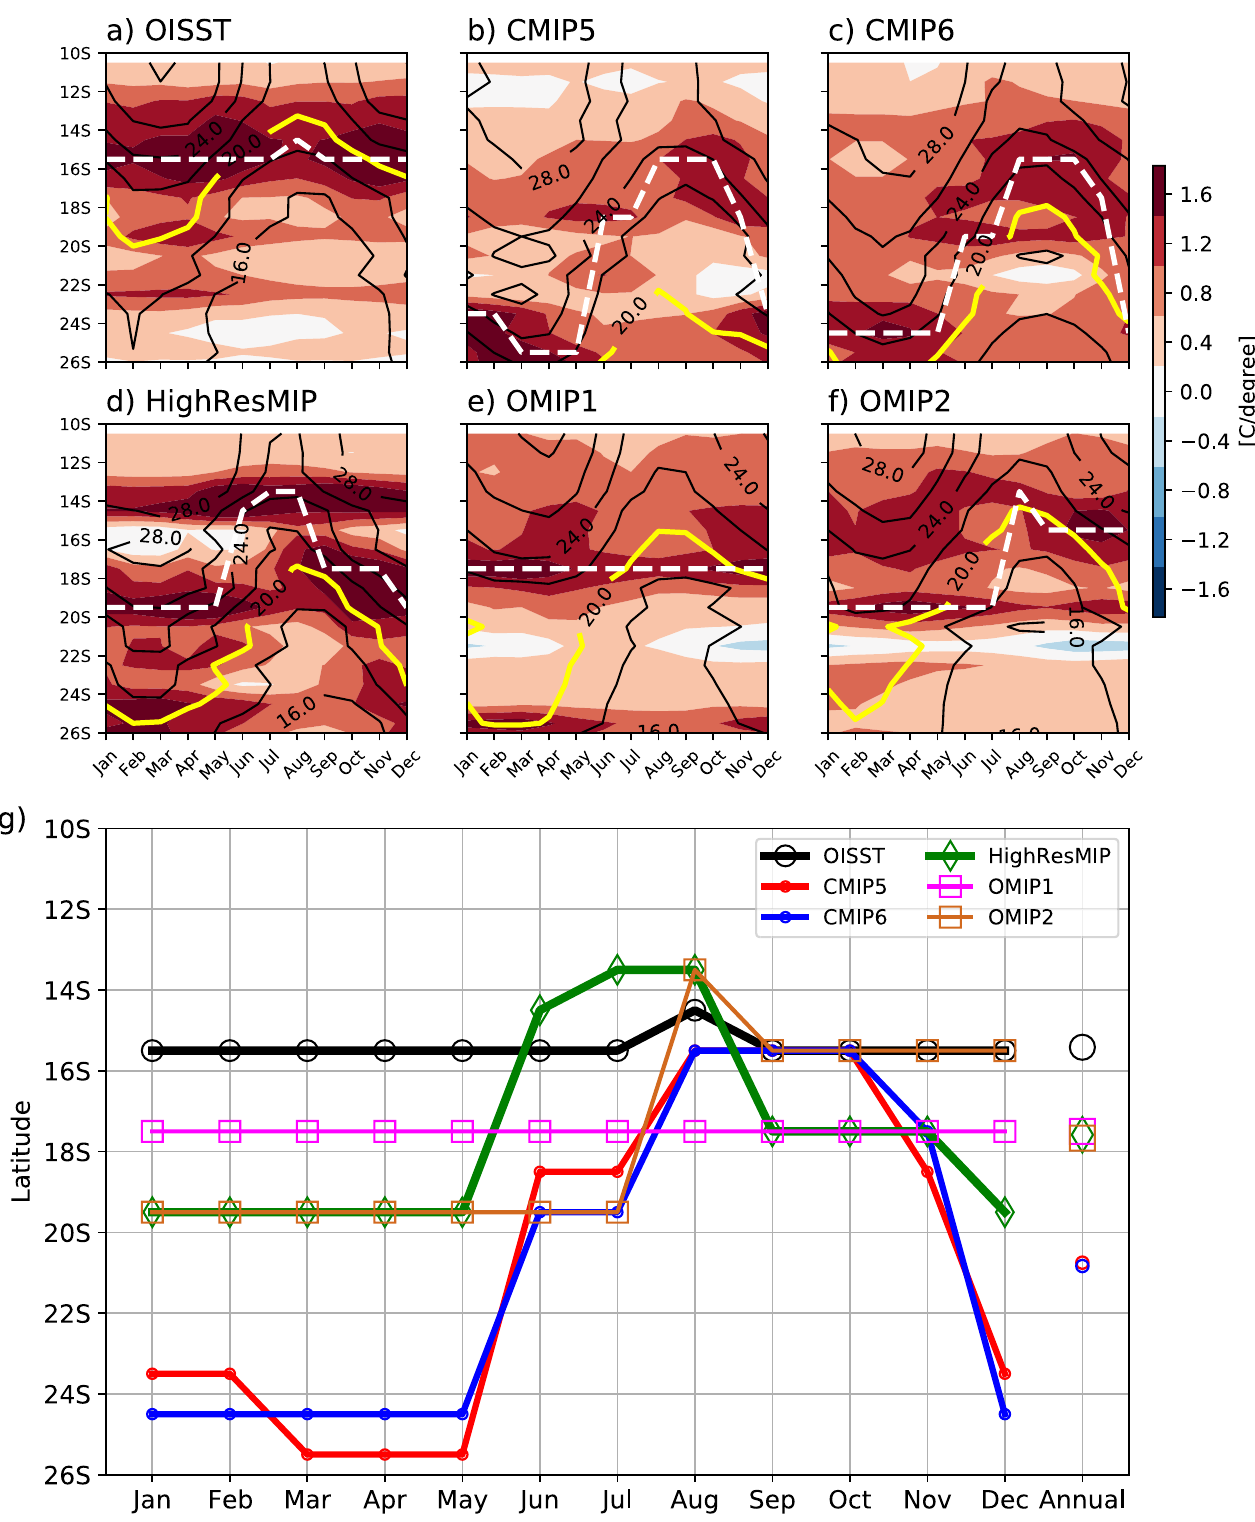
Fig. 4 Annual cycle of SST, its meridional gradient and seasonal variation of the ABF. a – f Climatological annual cycle of SST (contour) and its meridional gradient (shading) averaged zonally over a 2 ∘ wide band along the coast. The white dotted line shows the latitude of maximum gradient in SST at each month, whereas the yellow line marks the seasonal evolution of the 20 ∘ C isotherm. g Climatological latitudinal position of the Angola-Benguela Front (ABF), the front between the poleward Angola current and the equatorward Benguela current de fi ned by the latitude of maximum meridional SST